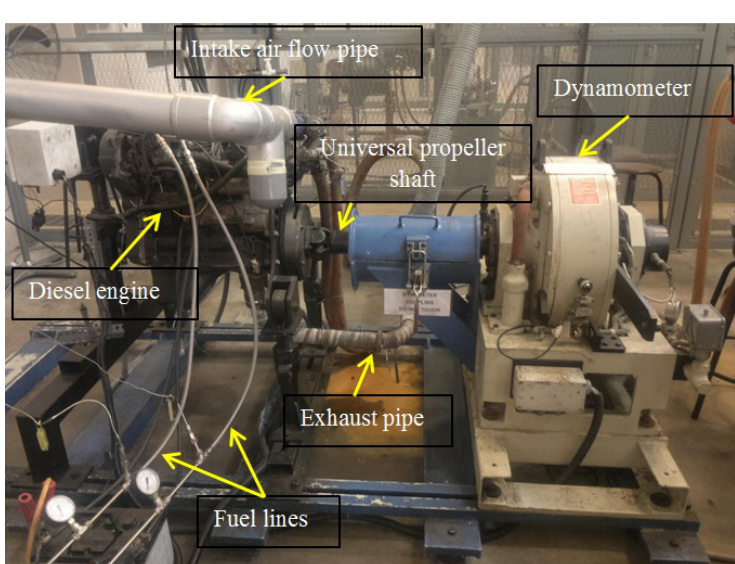
Figure 2. Experimental engine test